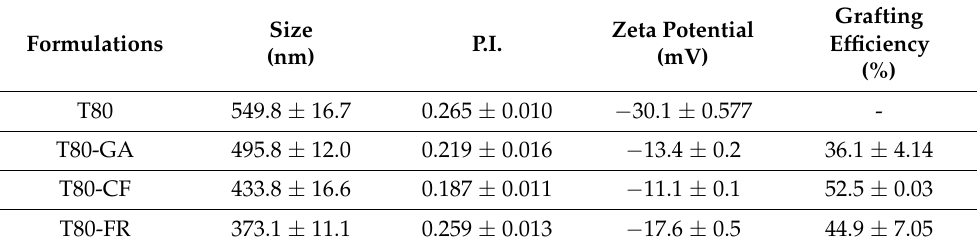
Table 2. Physicochemical properties (hydrodynamic diameter, polydispersity index (P.I.), and zeta potential) of curcumin-loaded niosomes before and after conjugation with phenolic acids at 25 °C. Data represent the mean ± S.D. of three independent experiments performed with triplicate meas- urements.